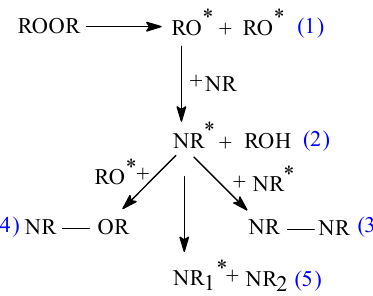
Figure 8. Mechanism of natural rubber cross-linking by peroxide.